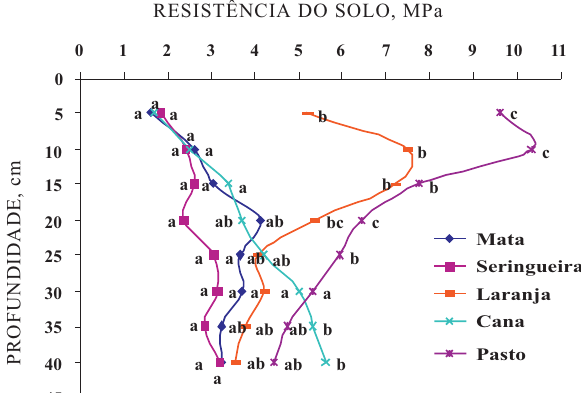
Figura 1. Resistência do solo à penetração para mata, seringueira, laranja, cana e pastagem, com umidade do solo de 0,117; 0,229; 0,167; 0,166; e 0,154 kg kg -1 , respectivamente. Valores seguidos pela mesma letra, em cada profundidade, não diferem estatisticamente entre si pelo teste de Tukey a 5